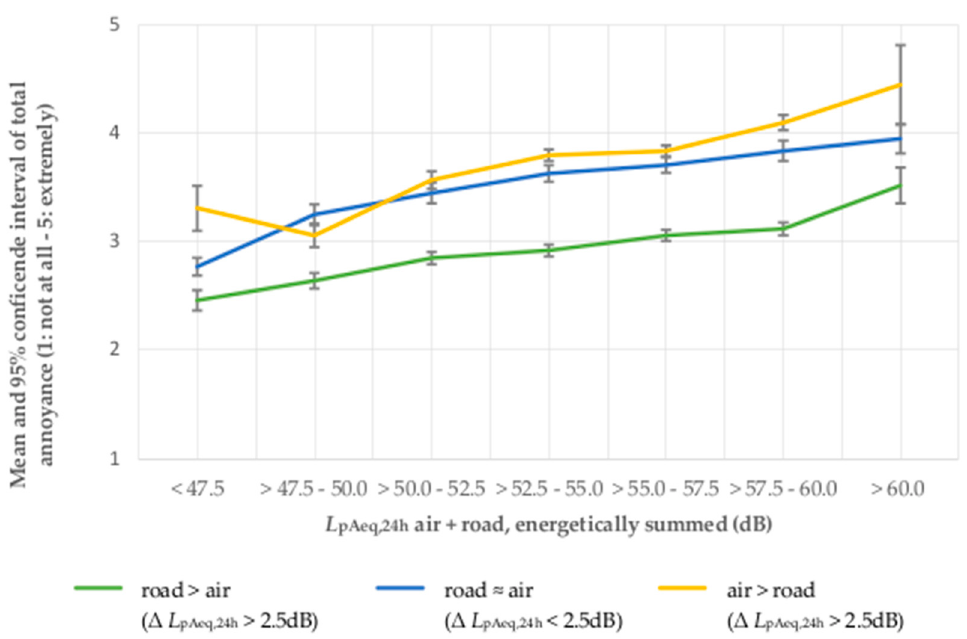
Figure 5. Total noise annoyance by aircraft and road traffic noise in association with the sound level dominance of the energetically summed 24-h average sound pressure level.